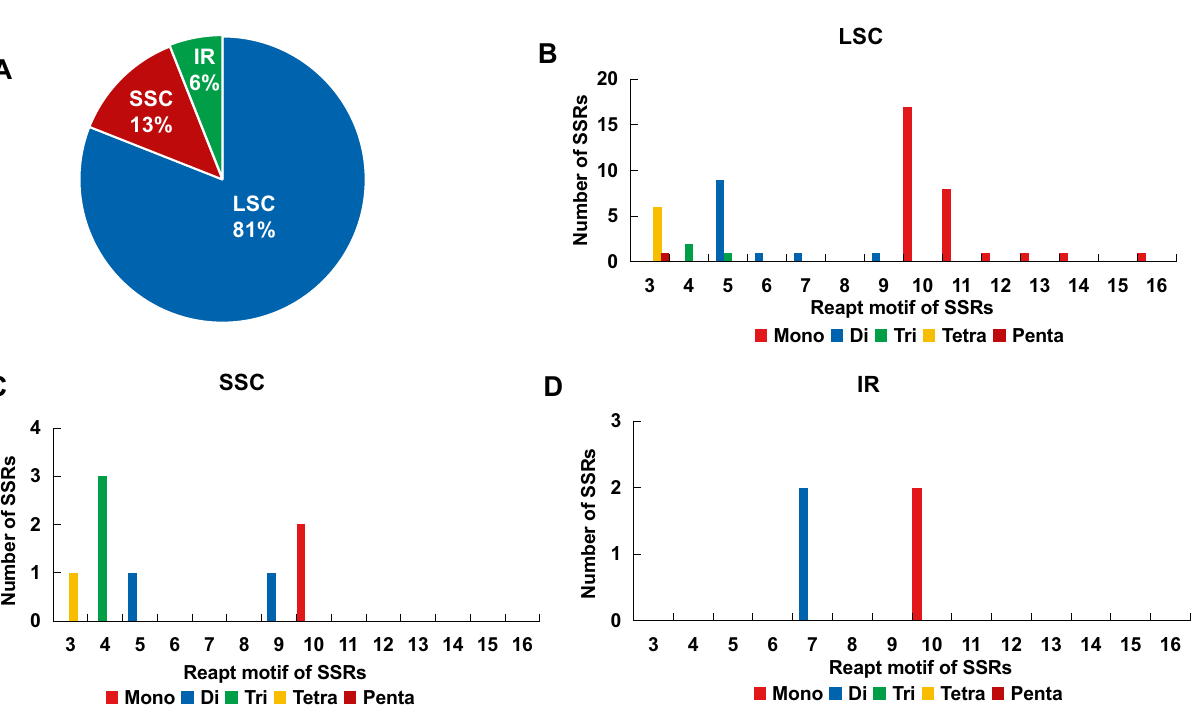
Figure 5. Distribution, type, and frequency of the repeat types of SSRs in the chloroplast genome of A. episcopale . ( A ) Presence of SSRs in the LSC, SSC, and IR regions. ( B–D ) Presence of polymers in the LSC, SSC, and IR